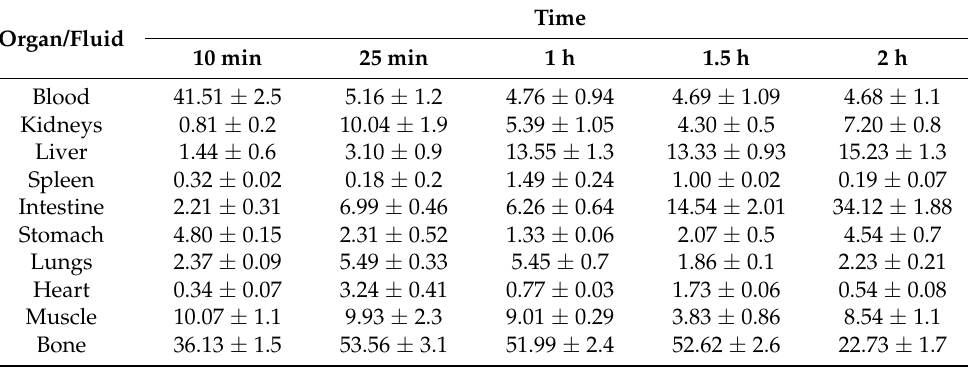
Table 2. Biological distribution of 99m Tc-phosphinothricin complex in mice as a function of time (%ID/organ ± S.D., n = 3).